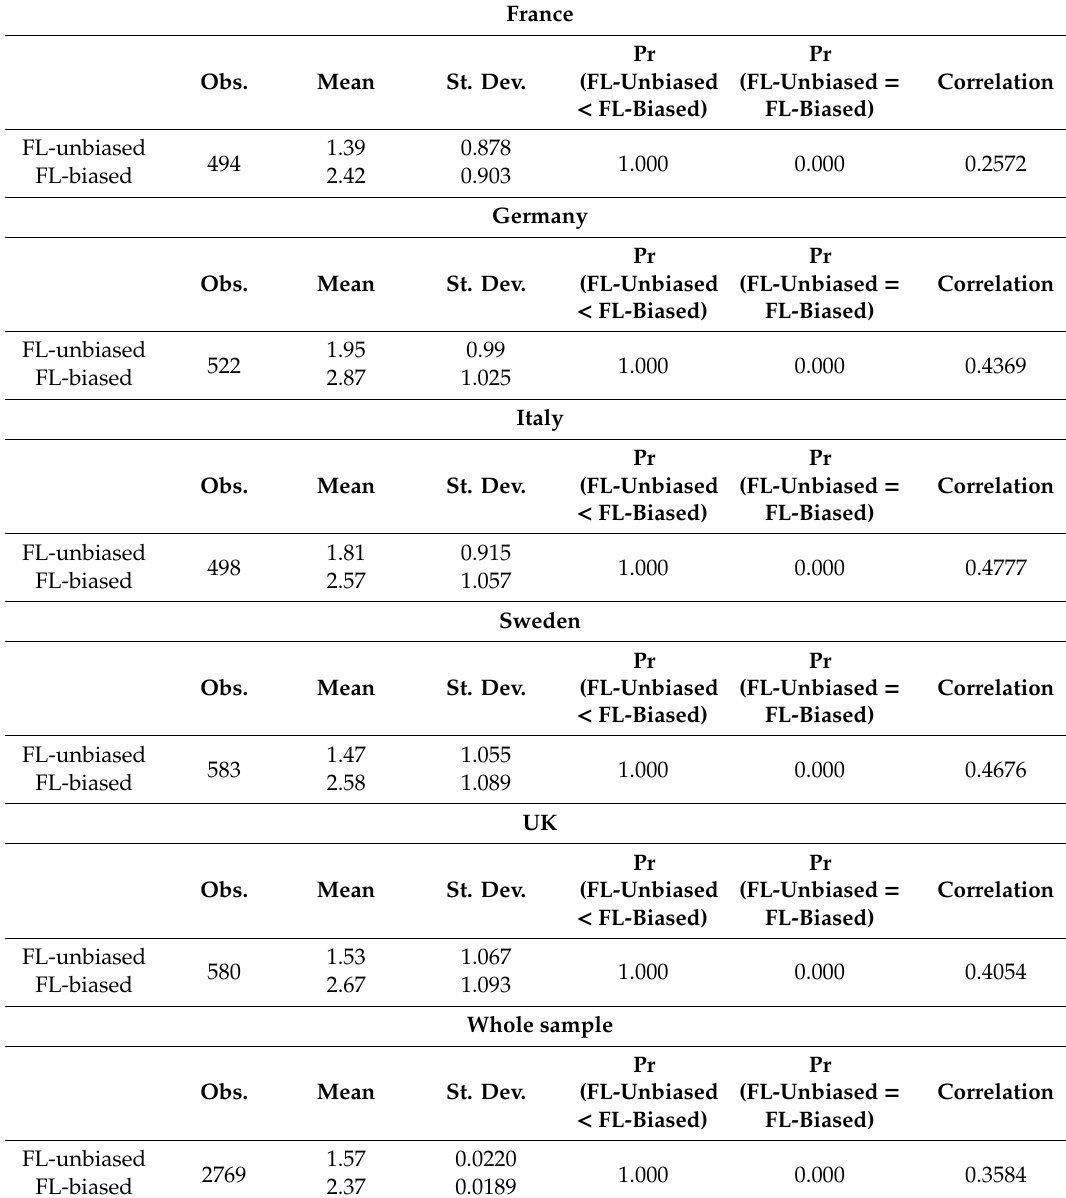
Table 2. Biased- and unbiased-financial literacy